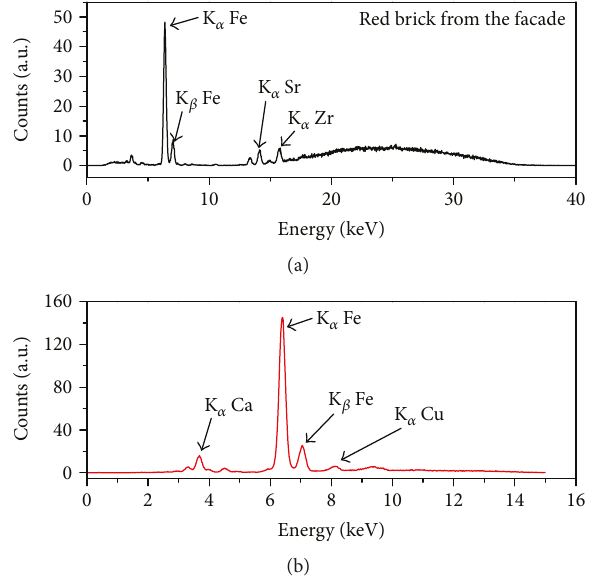
Figure 12: XRF spectra, in the 0 – 40keV range (a) and 0 – 16keV range (b), of a red brick from the facade of the Abbey of SS. Pietro